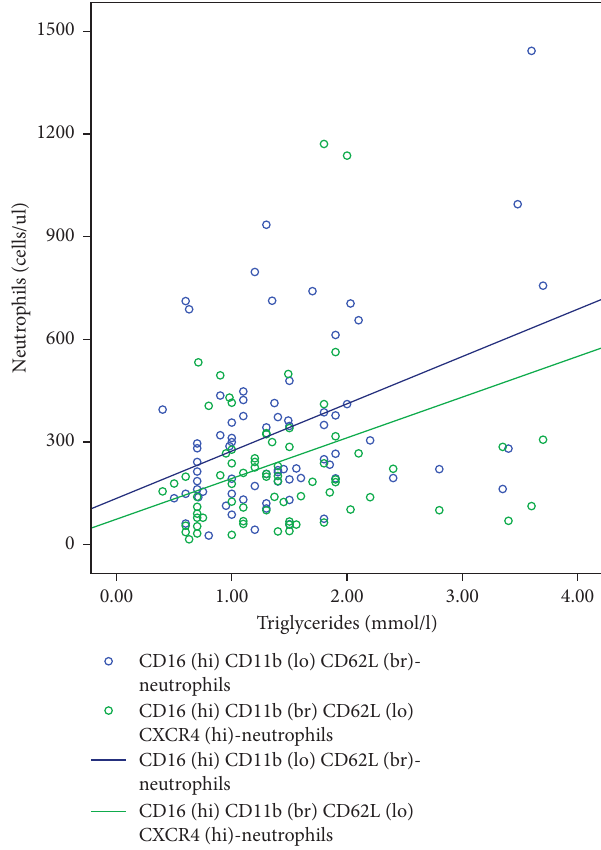
Figure 3: Relationship between TG and circulating neutrophil